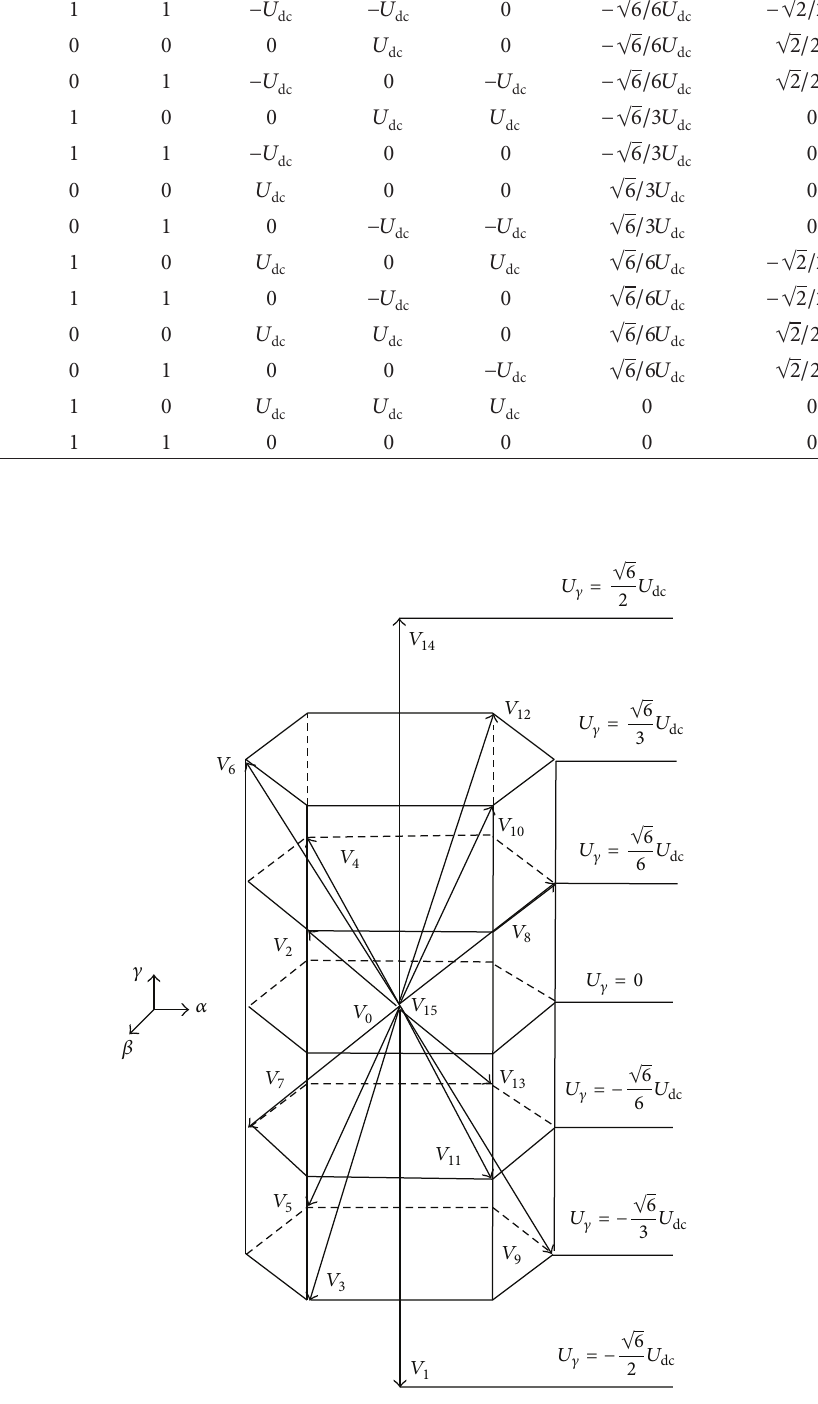
Figure 4: The switching vectors under the 𝛼𝛽𝛾